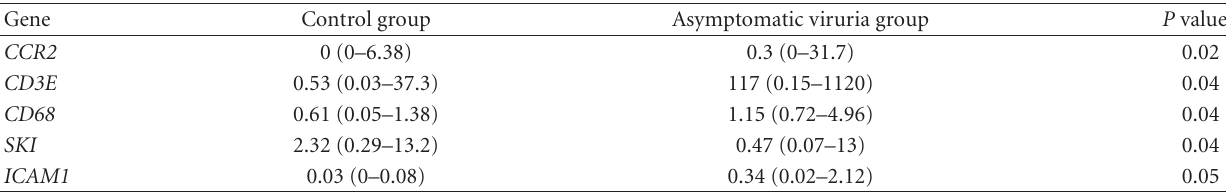
Table 2: Genes with di ff erent regulation in asymptomatic viruria group.